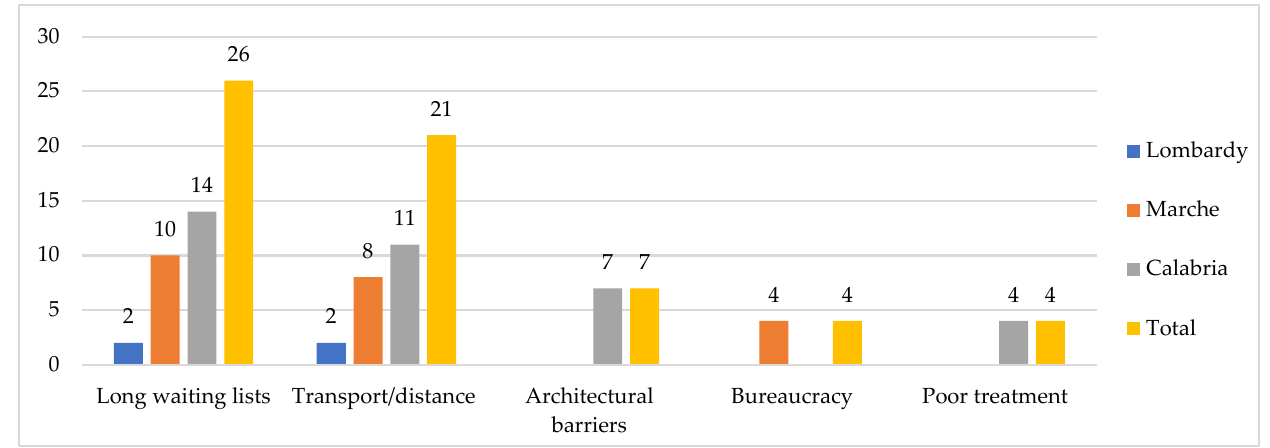
Figure 4. Barriers for using public health services, by region (n). Some respondents reported more than one type of listed barriers.